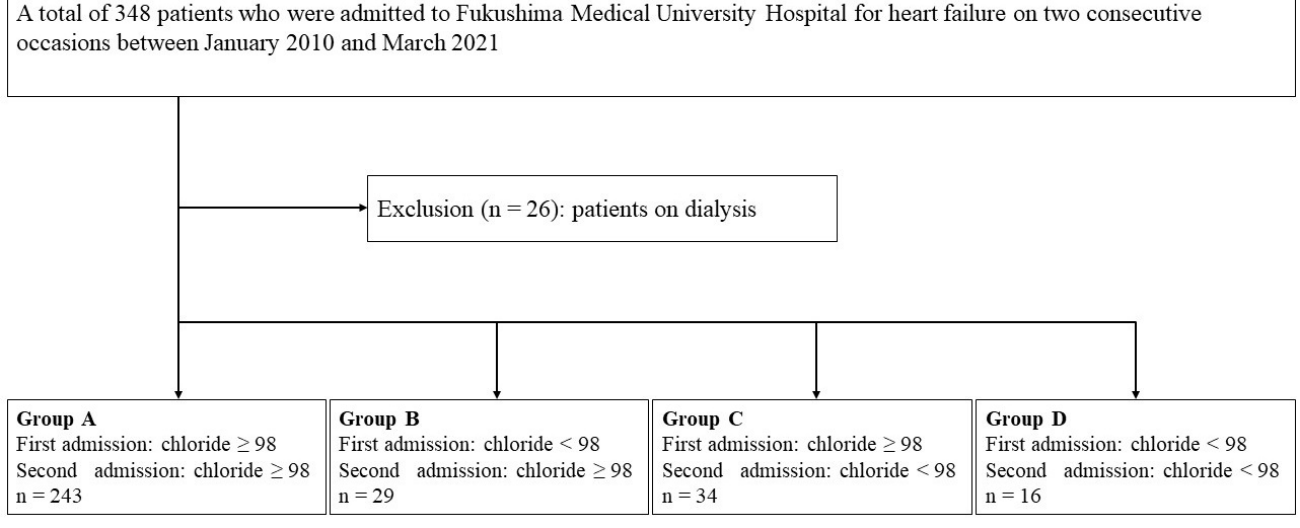
Figure 1. Patient